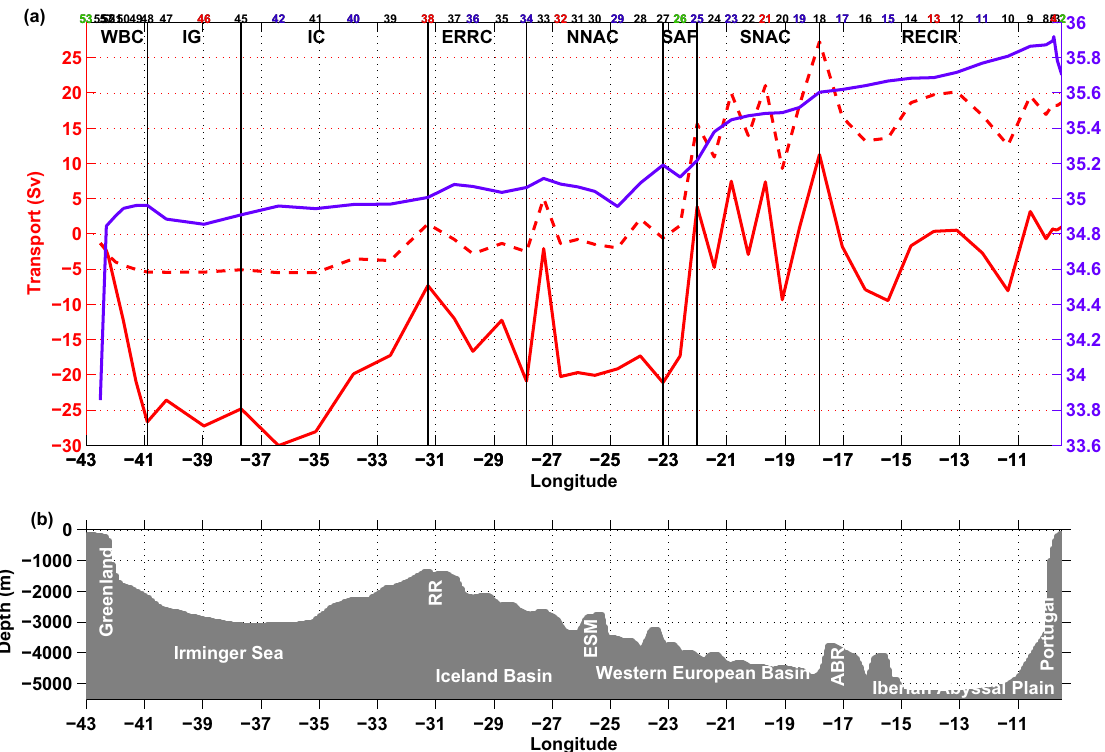
Figure 4. (a) Stream function or volume transport horizontally accumulated from Greenland to each GEOVIDE station down to Portugal and vertically accumulated in the upper limb of the MOC (red discontinuous line) and in the whole water column (red continuous line). The mean salinity in the upper limb of the MOC is also shown by the blue line and labeled on the right-hand axis. Acronyms at the top of the figure indicate the different components of the circulation crossing the OVIDE section as defined in Fig. 2. See Fig. 3 for station numbers and bathymetry legend. (b) Bathymetry along the OVIDE section; acronyms as in Fig.